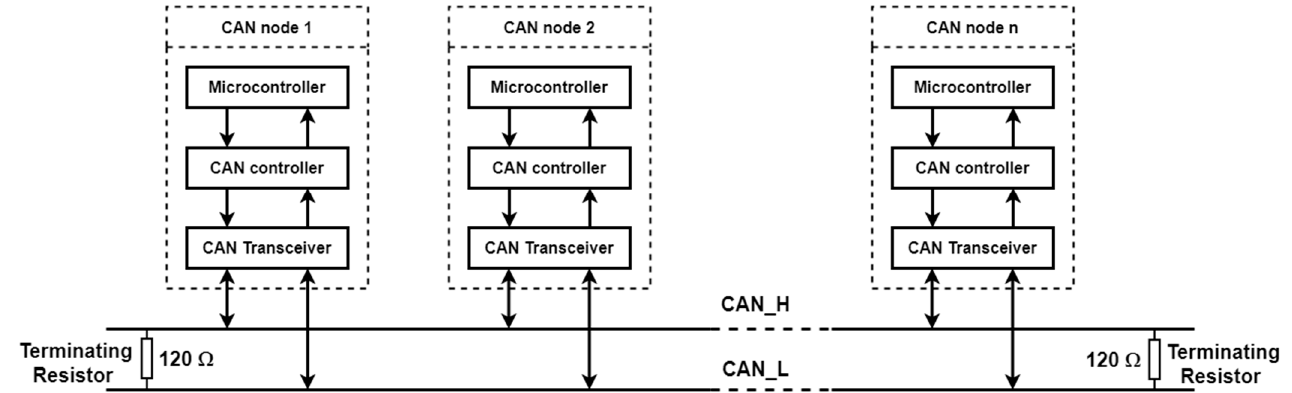
Figure 8. Structure of CAN bus with microcontroller.